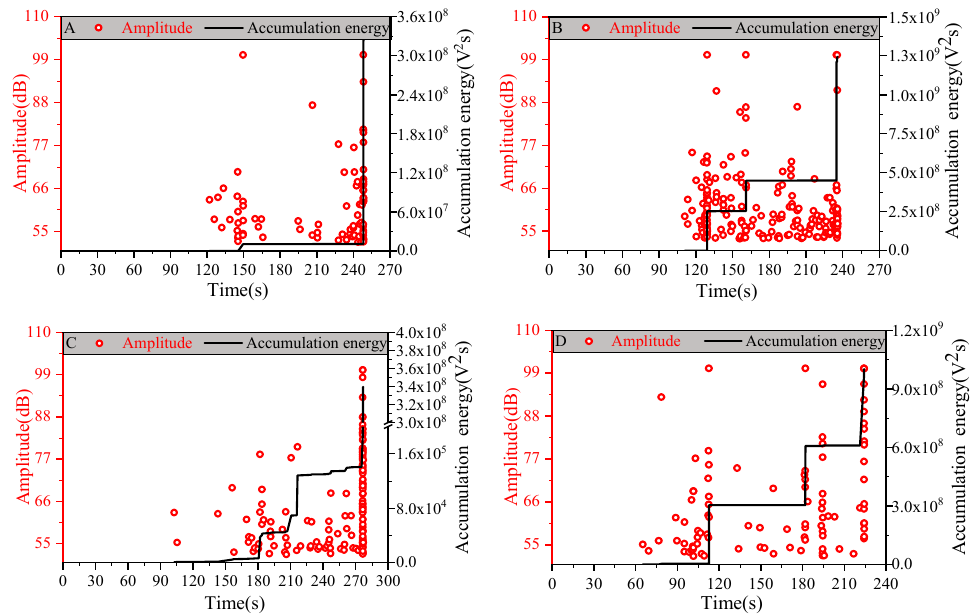
Figure 7. Acoustic amplitude and accumulation energy–time relationship graphs: ( A ) Group A, ( B ) Group B, ( C ) Group C, and ( D ) Group D.